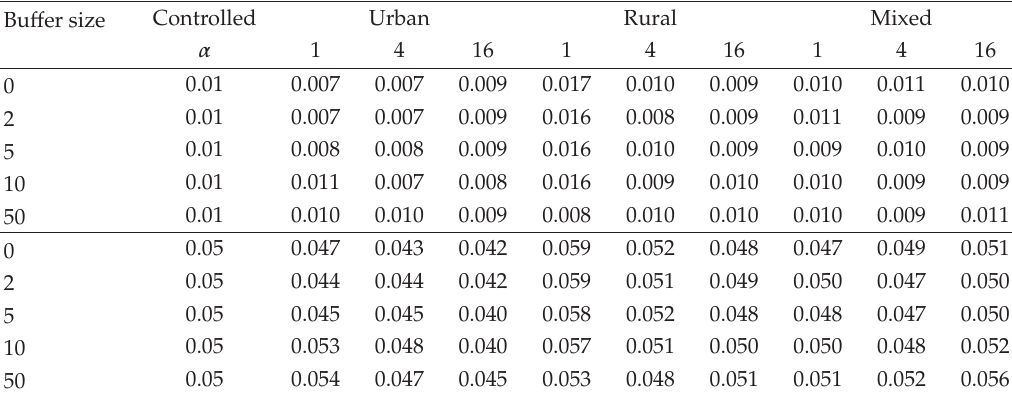
Table 1: Estimated type I error probabilities when testing the second most likely cluster when there is only one true cluster present, using the most likely cluster removing method. The bu ff er size is the number of neighboring counties removed together with the true cluster. The true clusters consist of 1, 4 or 16 counties located in an urban, rural or mixed population area, respectively, as described in the